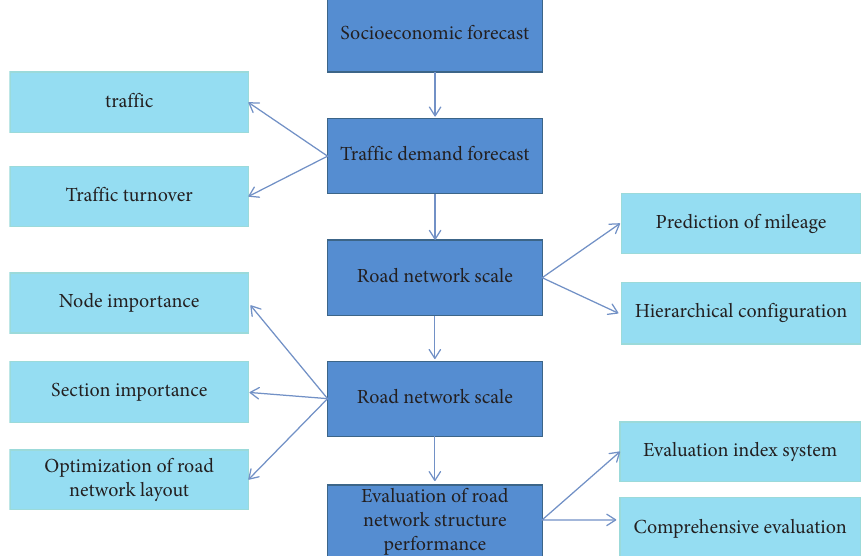
Figure 4: Framework diagram of rural road network planning system.